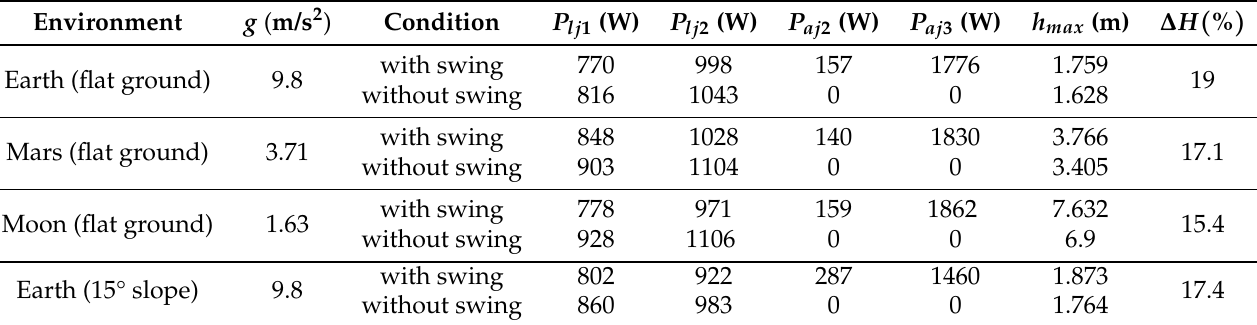
Table 4. The comparison of jumping performance with or without arm swing in different environments. ( P lj 1 , P lj 2 , P aj 2 and P aj 3 are the peak power of leg Joint1, leg Joint2, arm Joint2 and arm Joint3, respectively. ∆ H represents the percentage of jump height